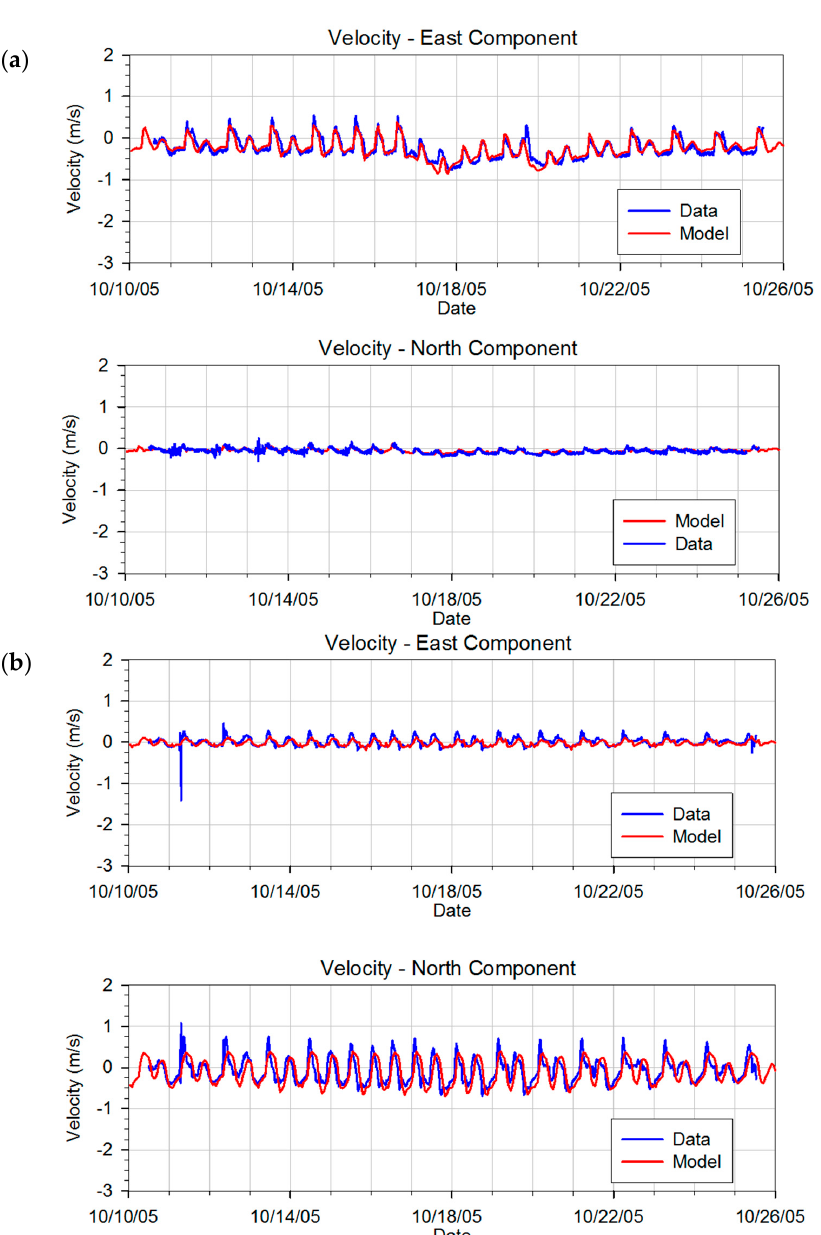
Figure 4. Comparison of predicted and measured velocity components at the Hatt Slough ( a ) and South Pass ( b ) stations, respectively. Data is from mid-depth of the water column. Error statistics comparing measured versus simulated velocity are also provided in Table 2. The comparison was done for a mid-depth layer at both sites. Model predictions match the field data well at a reasonable level of accuracy. Overall, the RMSE in the north and south directions is less than 14 cm/s, and the mean absolute error is 7 cm/s, except at the Hatt Slough station. This represents < 10% error relative to the range of current magnitudes in the Stillaguamish River estuary.